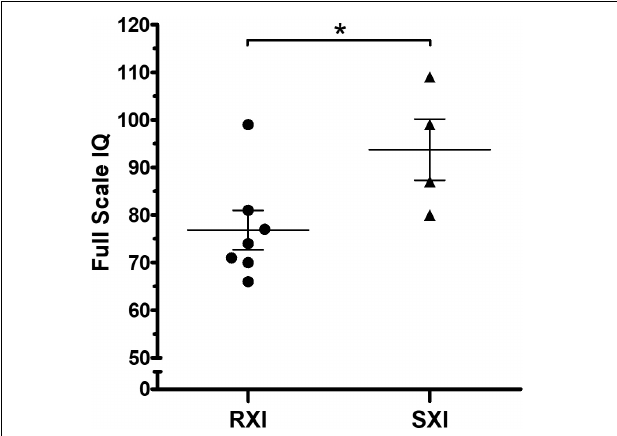
FIGURE 1 | Intelligence quotient scores in Klinefelter syndrome according to the X-chromosome inactivation pattern. RXI patients ( n = 7) show a lower IQ mean than SXI patients ( n = 4). The mean IQ from patients with RXI was at borderline levels (Mean = 76.86), while in the SXI patients, it was average (Mean = 93.75). Data are presented as mean ± SEM. Statistical analysis used the t -test (* p = 0.0451). IQ, intelligence quotient. RXI, random X-chromosome inactivation; SXI, skewed X-chromosome